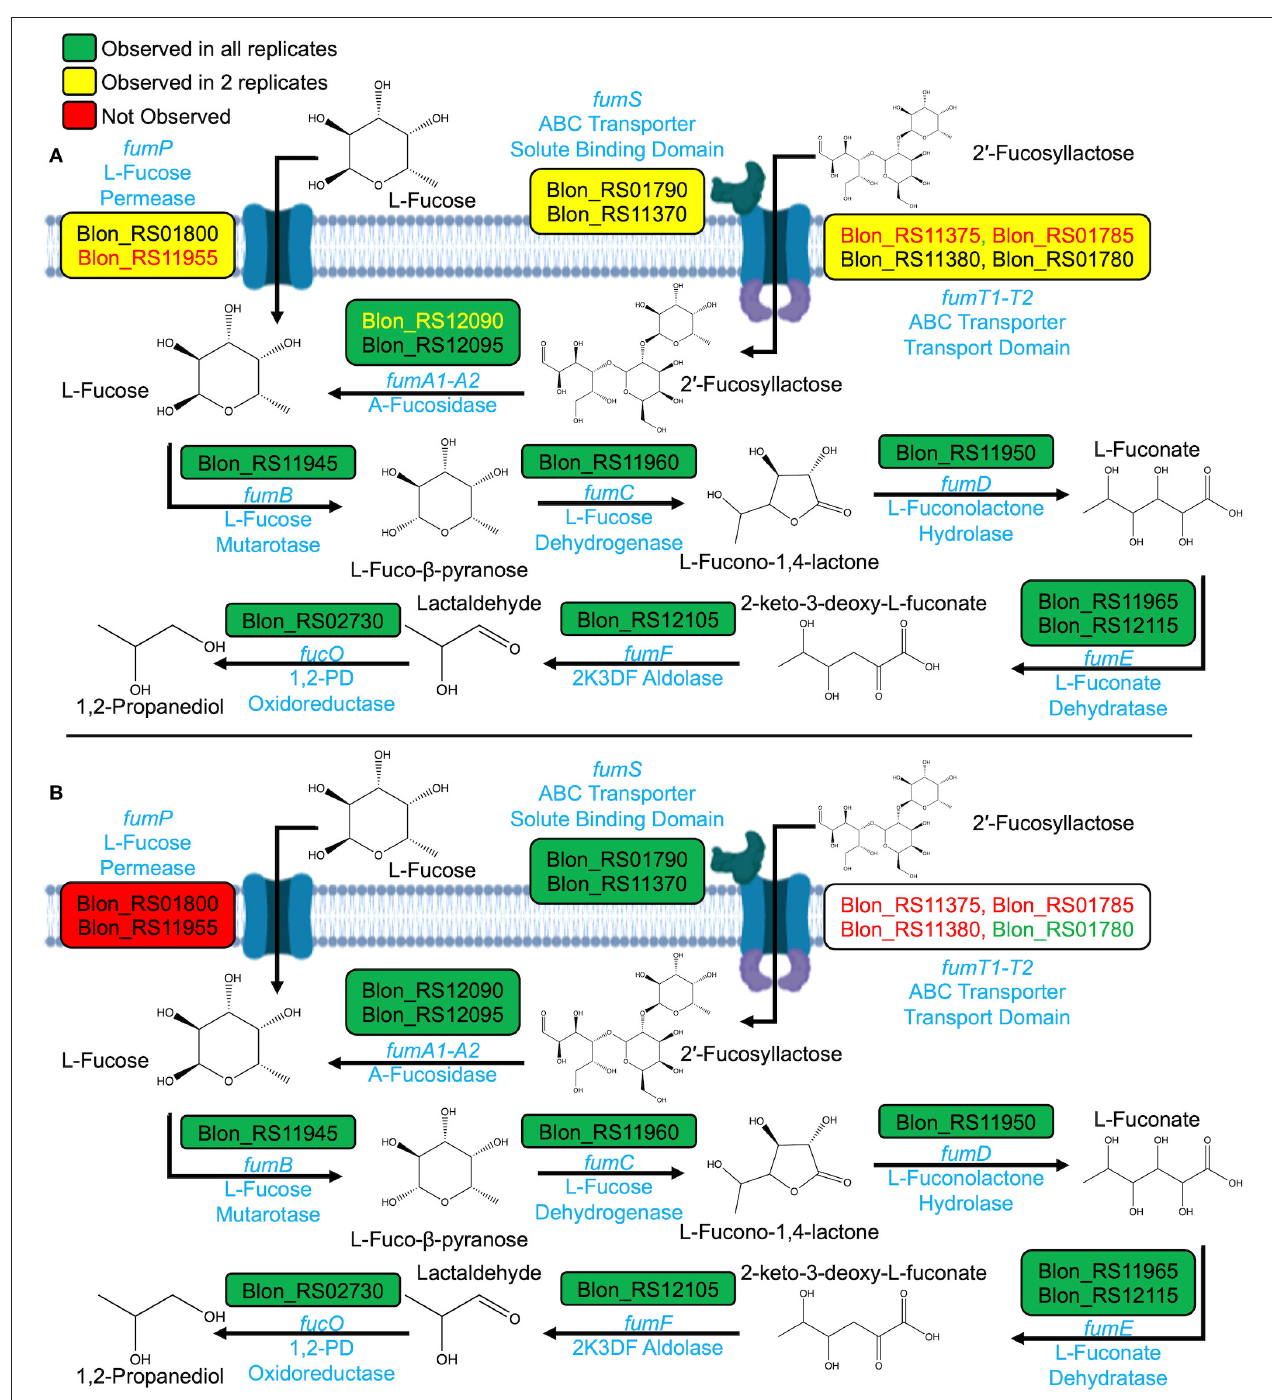
FIGURE 4 | Proposed fucose pathways based on proteome during growth on (A) free fucose and (B) 2% 2 ′ fucosyllactose as sole carbohydrate sources. Gene symbols are given in light blue above the reaction arrows and corresponding protein names below.